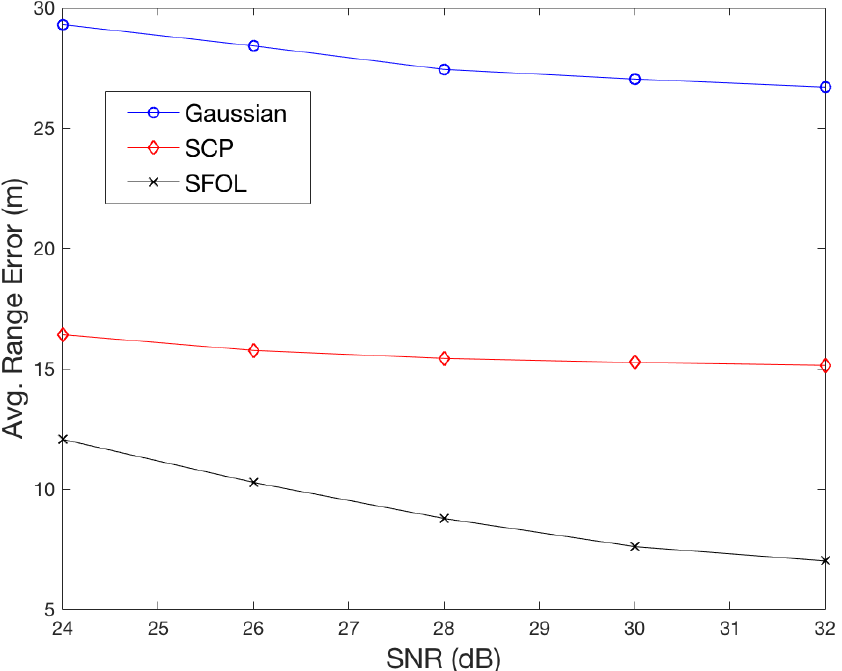
Figure 3. Averaged root mean square (RMS) range errors in 1000 cases of noise injection with five levels of signal-to-noise ratio (SNR).